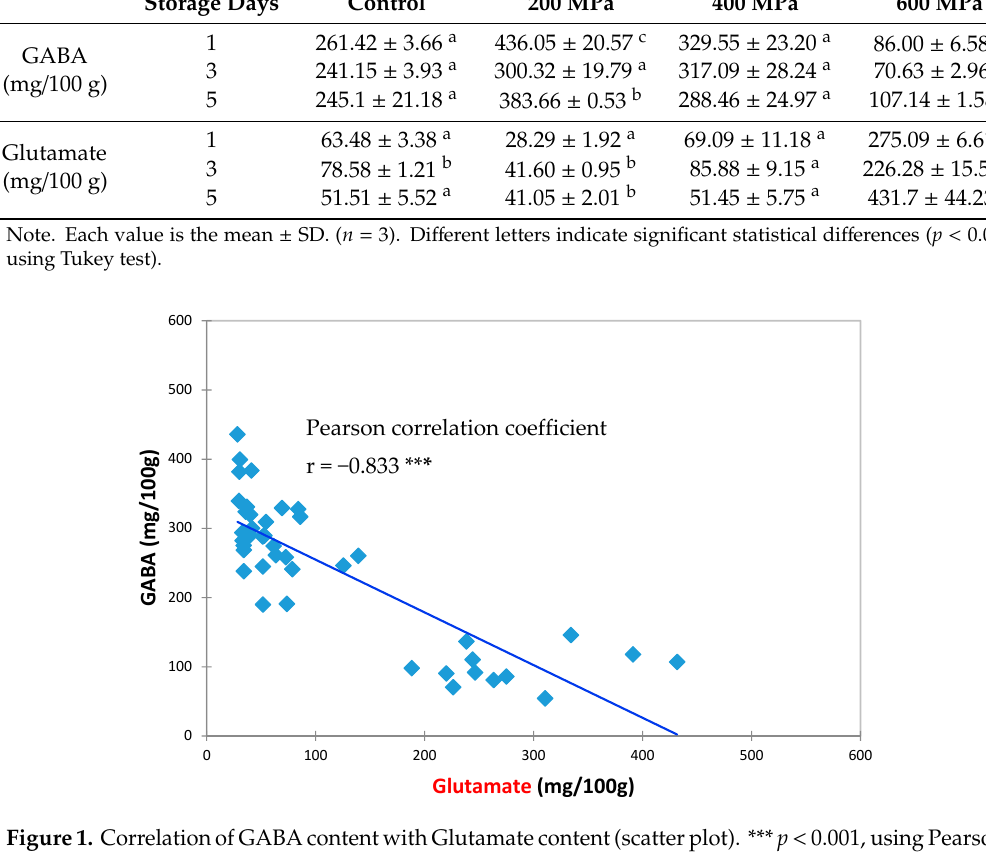
Figure 1. Correlation of GABA content with Glutamate content (scatter plot). *** p < 0.001, using Pearson correlation test .